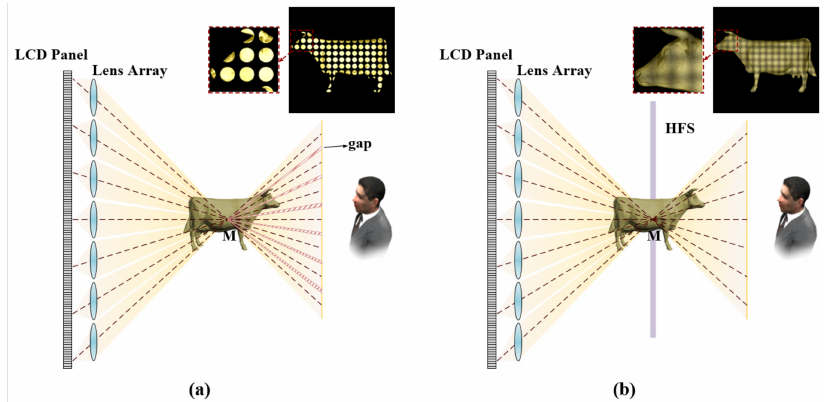
Figure 1. The schematic diagram ( a ) without HFS, and ( b ) with